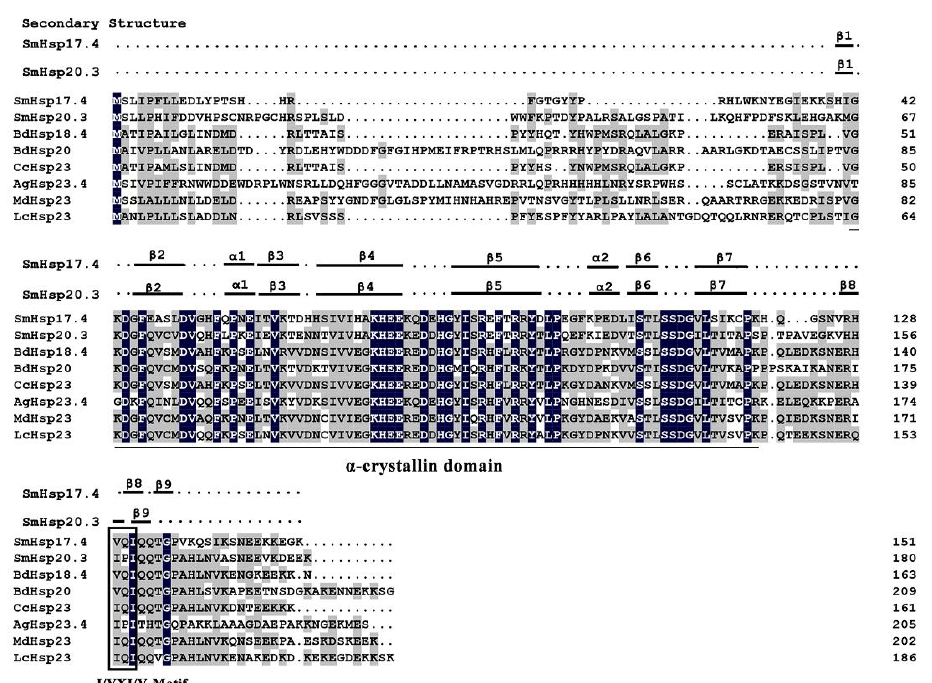
Figure 1. Amino acid sequence alignment of SmHsp17.4, SmHsp20.3, and s mall heat shock proteins (sHsps) from other insect species. Identical and similar residues are shaded black and grey, respectively. The α -crystallin domain is underlined and the I/VXI/V motif is boxed. Putative secondary structures are labeled above sequences as α ( α -helices), β ( β -strands), and dotted lines (coils), respectively. Sm, Sitodiplosis mosellana ; Bd, Bactrocera dorsalis ; Cc, Ceratitis capitata ; Ag, Anopheles gambiae ; Md, Musca domestica ; and Lc, Lucilia cuprina .